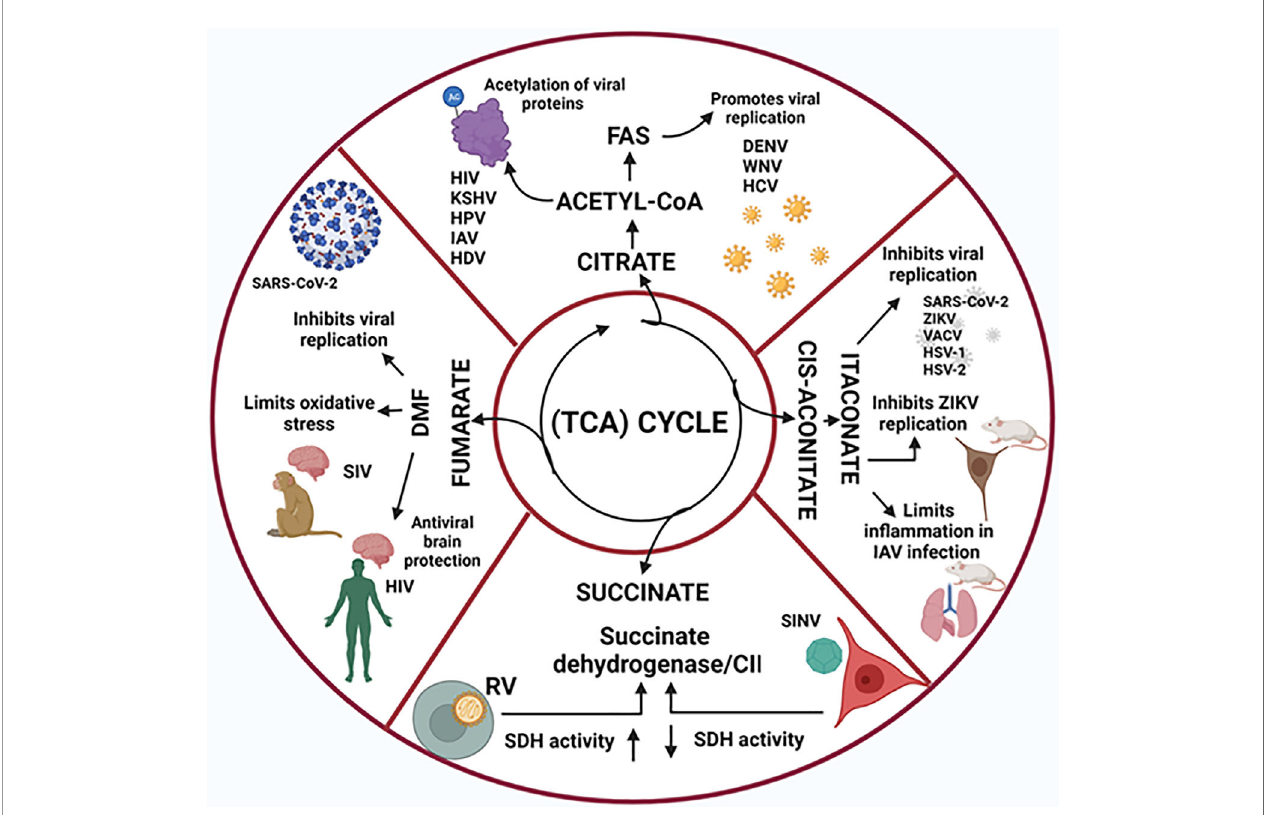
FIGURE 2 | Tricarboxylic acid (TCA) cycle-derived metabolites and their role in viral infections. The TCA cyce intermediate metabolites citrate, succinate and fumarate play key roles in vral replication and in the virus-induced in fl ammation process. In addition, itaconate, which is synthesized from the TCA cis-aconitate, is also endowed with anti-in fl ammatory and anti-viral